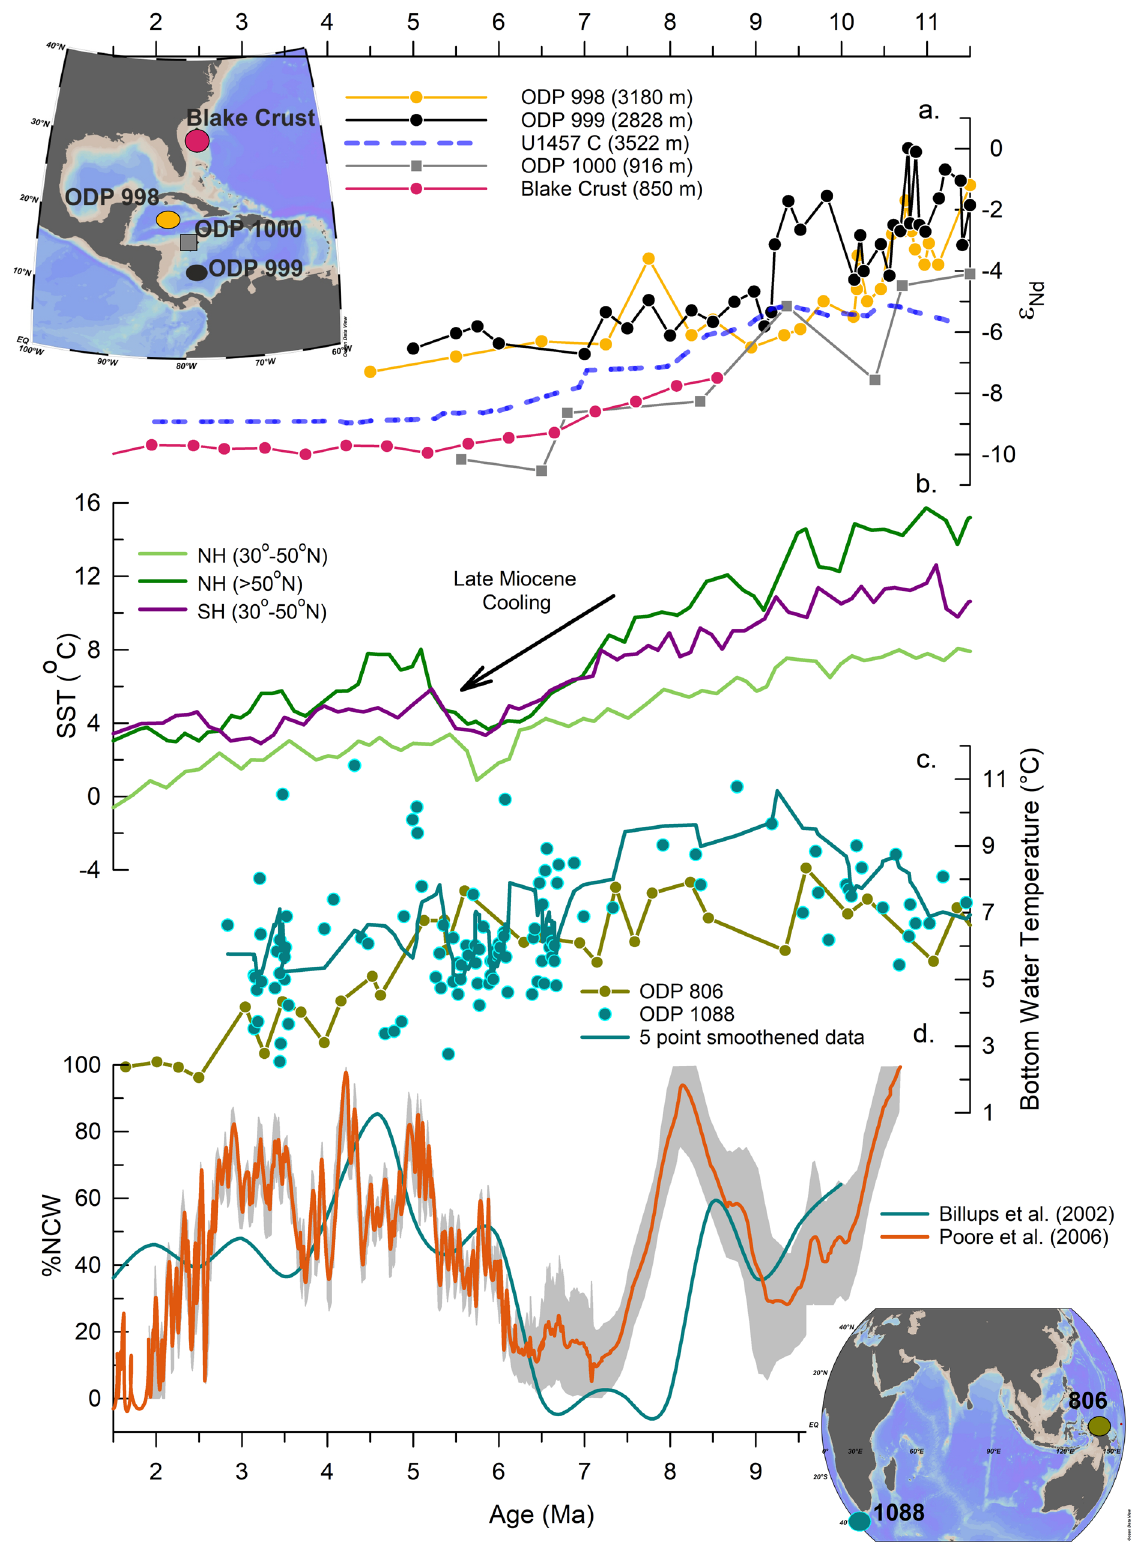
Fig. 4 | Evolution ofdeepwater circulationsince the lateMiocene.a ε Nd record from the Caribbean Sea, Atlantic Ocean ODP 998, 999 54 , ODP 1000 53 , Blake Fe-Mn Crust 44 ; b Sea surface temperature (SST) for the subtropical and high latitude northern hemisphere (NH) and southern hemisphere (SH) 55 ; c bottom water